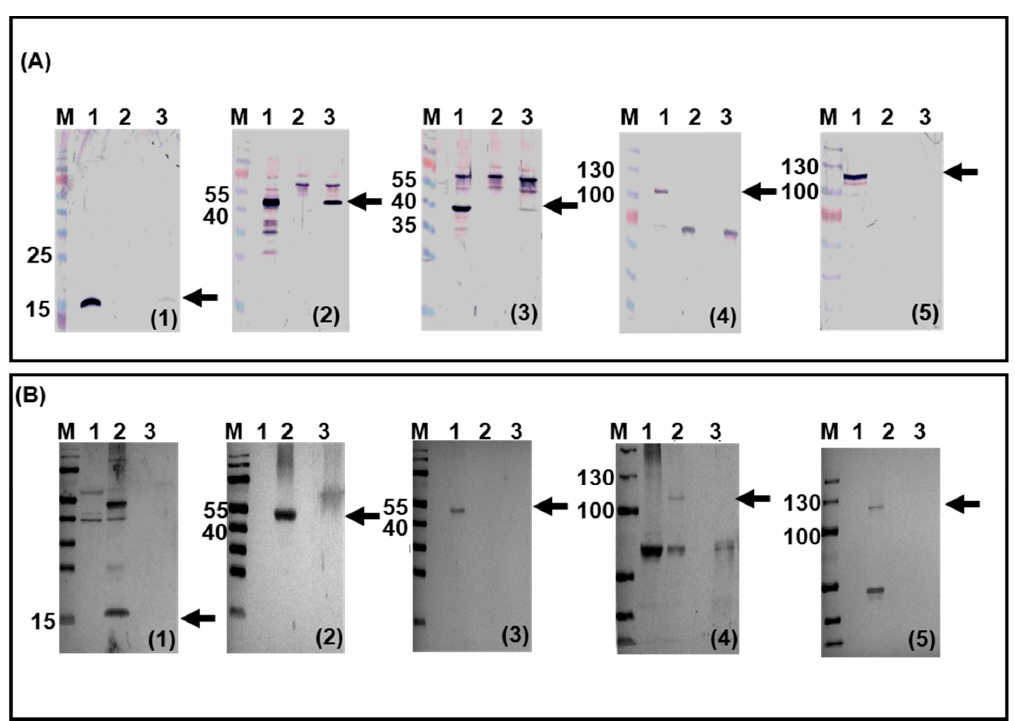
Figure 4. Viral protein expression in BAV304a-infected cells. Monocytes ( A ) and PMNs ( B ). The infected cell lysates were separated with 12% SDS-PAGE, transferred to nitrocellulose membranes and probed in Western blot using BAdV-3 anti-19K serum (subpanel 1 ), BAdV-3 anti DBP serum (subpanel 2 ), BAdV-3 anti-52Kserum (subpanel 3 ), BAdV-3 anti-hexon serum (subpanel 4 ), and BAdV-3 anti-100K serum (subpanel 5 ). BAV304a-infected MDBK cells (panel A , lanes 1; panel B lanes 2); BAV304a-infected monocytes (panel A , lanes 3) or PMNs (panel B , lanes 2); mock-infected monocytes (panel A , lanes 2) or PMNs (panel B , lanes 1); molecular weight markers (M) in kDa